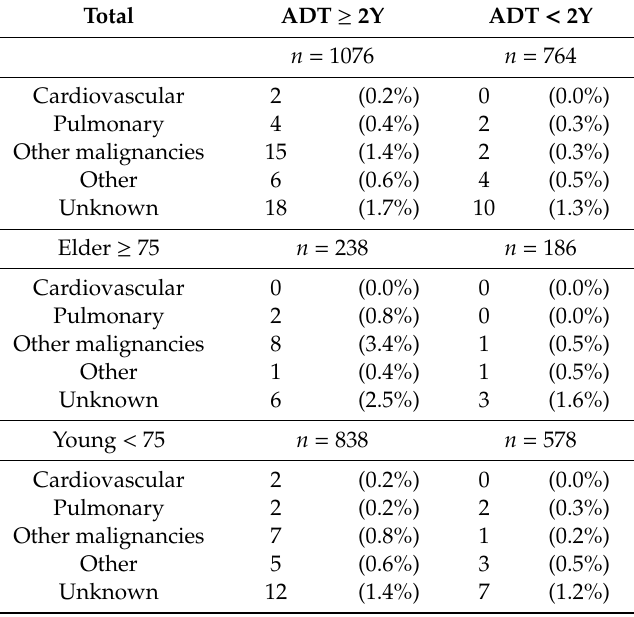
Table 6. Cause of other cause of mortality